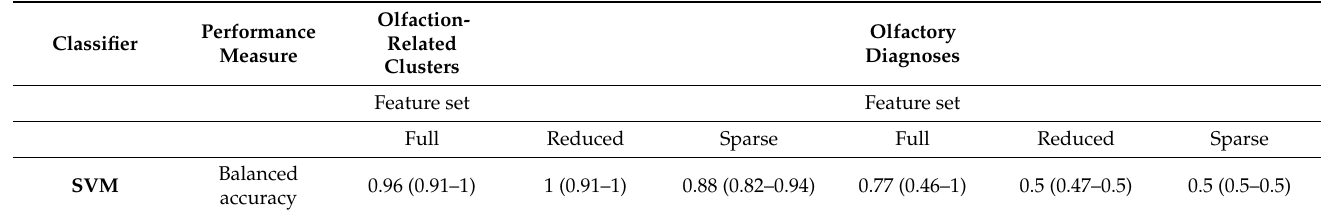
Figure 8. Differences in sum scores of selections of each variable across 17 feature selection methods when the target was the olfaction-related cluster versus the target defined as the olfactory diagnosis of normosmia or hyposmia. The variables selected as informative for the cluster structure are plotted in darker blue. The figure has been created using Python version 3.8.12 for Linux (https://www.python.org, accessed on 28 January 2022) and Seaborn Python data visualization library (https://seaborn.pydata.org, accessed on 28 January 2022 [65]) and our Python package “ABCanalysis” (https://github.com/JornLotsch/ABCanalysis, accessed on 28 January 2022). Variable names, if not self-explaining: “olfthresh“ = olfactory threshold to phenyl ethyl alcohol (PEA), “olfdis” = score in the odor discrimination task, “olfident” = score in the odor identification task, log Distance right/left nostril” = perception of peanut butter odor from a distance, “Score PEA/EUG” = scores in the odor sorting tasks, “Lat correct assignments overall” score in the lateralization test. Table 2. Validation of the feature sets by training three different classifiers (linear support vector machine, SVM, random forests, and logistic regression) with subsets of the training dataset with all variables (d = 15 olfaction-related features and age, sex, and BMI) as “full” feature set and with the d = 6 variables that had resulted from the feature selection steps shown in Table 1 as “reduced” feature set. In addition, the classification task was repeated using only the variables “Score PEA“ and “Score EUG“ to test the hypothesis that these provide an informative addition to the olfactory test. The classification task was designed for the cluster assignment. In addition, after re-tuning the algorithms, the task was repeated with the olfactory diagnosis as target. Shown are the medians and nonparametric 95% confidence intervals (2.5th to 97.5th percentiles) from 100-fold cross-validation